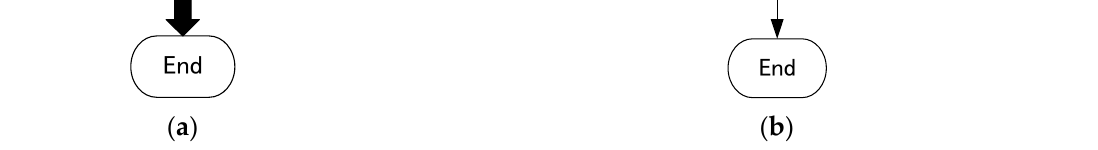
Figure 6. ( a ) Flowchart of MSSW-LSTM; ( b ) data processing of XJSS using MSSW-LSTM